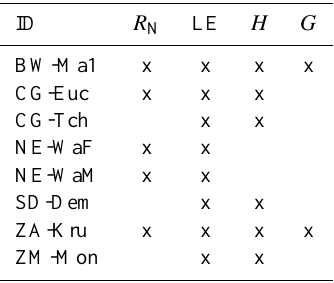
Table 5. Data availability ( R N =net radiation, LE=latent heat, H =sensible heat, and G =ground heat) for energy balance clo- sure at eight micrometeorological stations throughout sub-Saharan